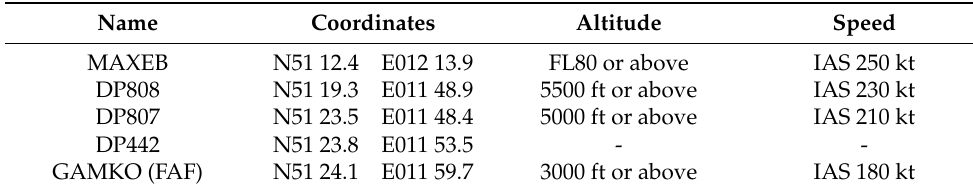
Figure 5. The horizontal route for the simulation. The arrival route for the CDO operation (CDO NIGHT) of RWY08R at Leipzig/Halle Airport, Germany (original source in black: AIP Germany [51], modified for research purpose in purple). The dotted lines and the symbols c , d 1 , · · · , d 6 show the phase separation. The lengths of c , d 1 and d 2 phases do not necessarily reflect reality in this figure. Table 1. Waypoints used for the simulation.